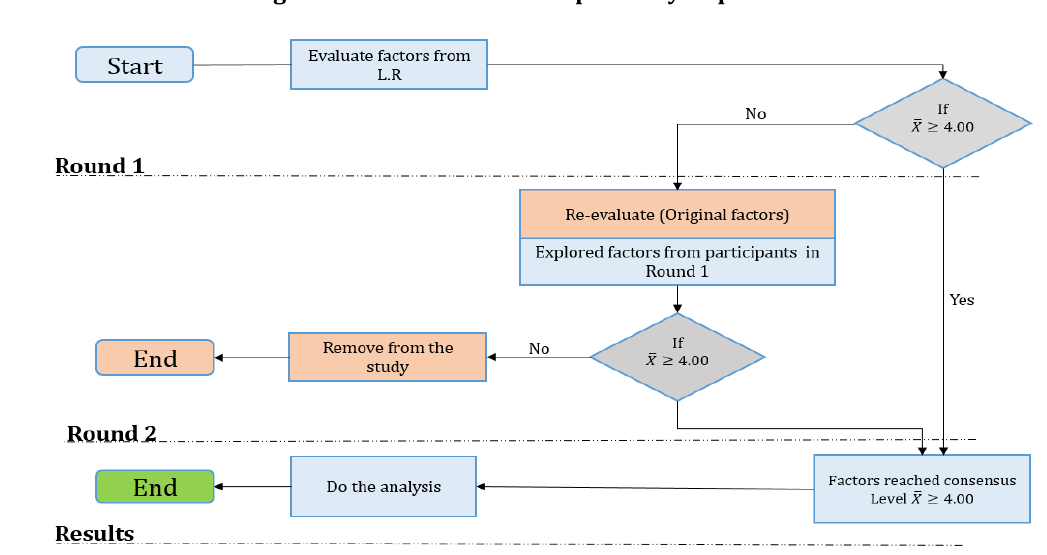
Figure 1: The two-round Delphi analysis